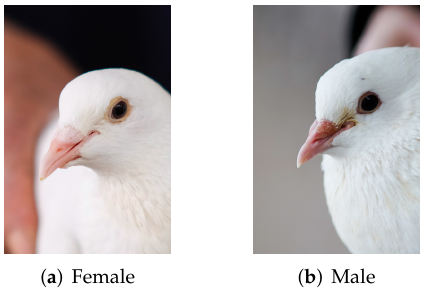
Figure 3. Comparison of the heads of female pigeons and male pigeons.